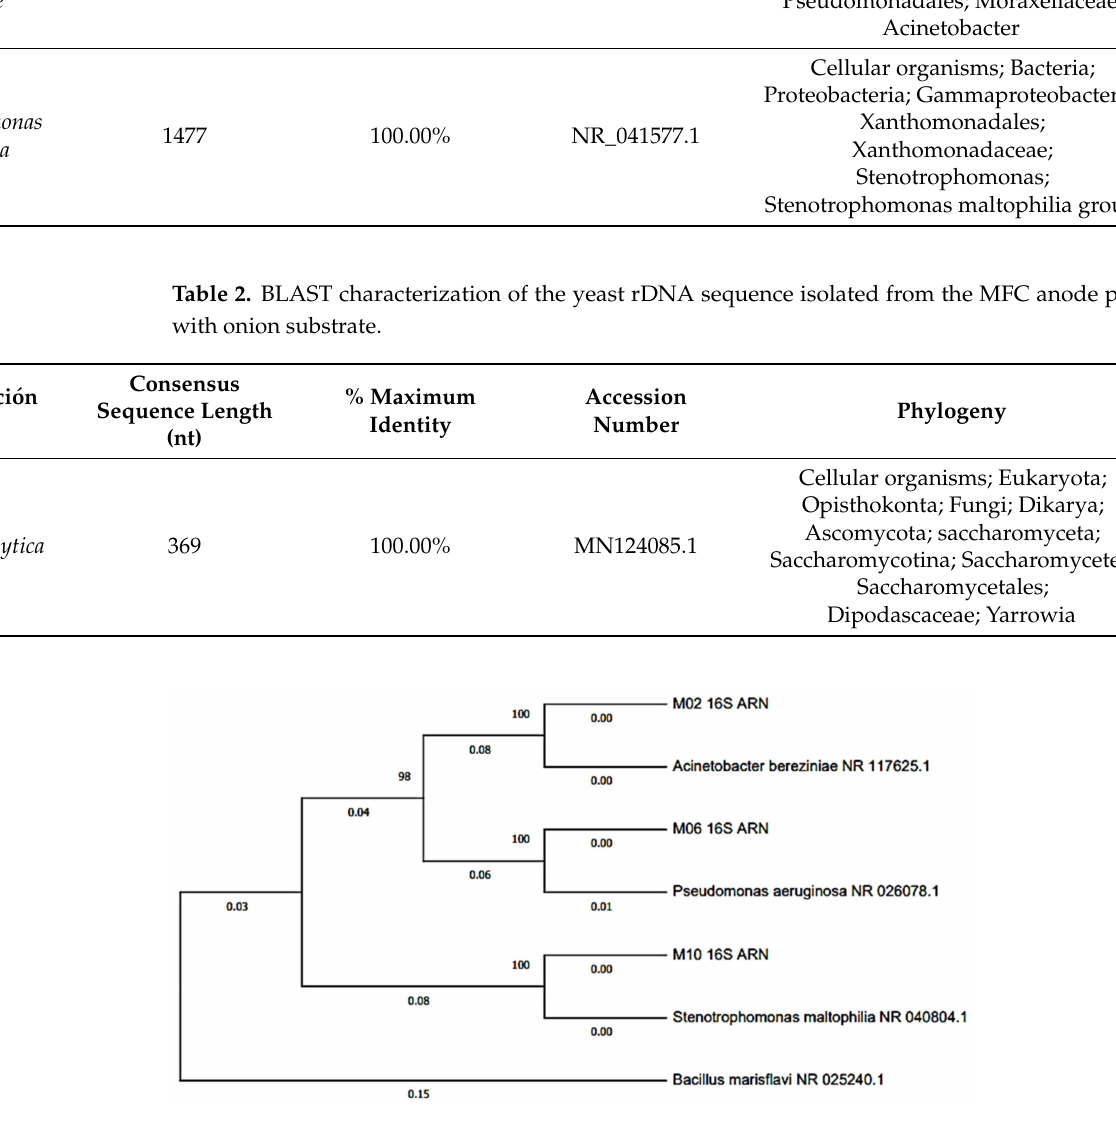
Figure 6. Dendrogram of groups of bacteria isolated from the MFC anode plate with onion substrate. A study by Ali et al. exposed the efficiency of using the species Pseudomonas erug- inosa, which generated 136 ± 87 mW/m 2 from the use of glucose, followed by fructose and sucrose. This study observed that the cell fed with glucose presented higher bacterial adhesion [66]. On the other hand, Acinetobacter bereziniae was identified as a